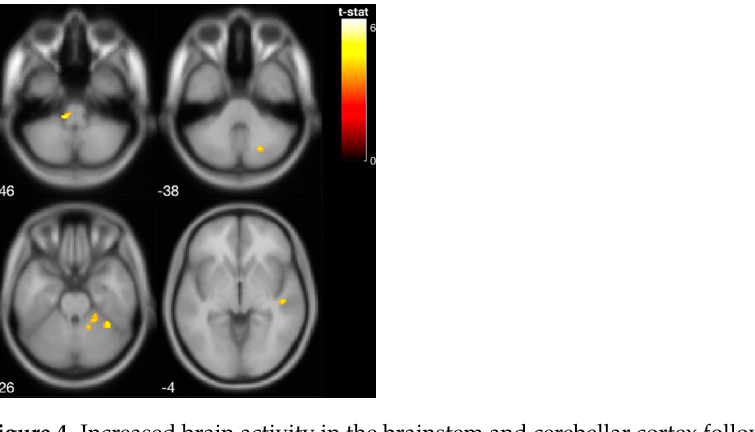
Figure 4. Increased brain activity in the brainstem and cerebellar cortex following balance training with vibrotactile SA (i.e., increased activation from pre- to post-training with vibrotactile SA) for the four EG participants that were scanned. Table 1. Activated brain regions in response to vestibular stimulation at pre-training, post-training, and pre- vs. post-training (i.e., increased activation from pre- to post-training). Following balance training, the brain activity shifted from the vestibular cortex to the cerebellum and vestibular nucleus in the brainstem. The results are shown at p < 0.001 (unc.). MNI: Montreal Neurological Institute.